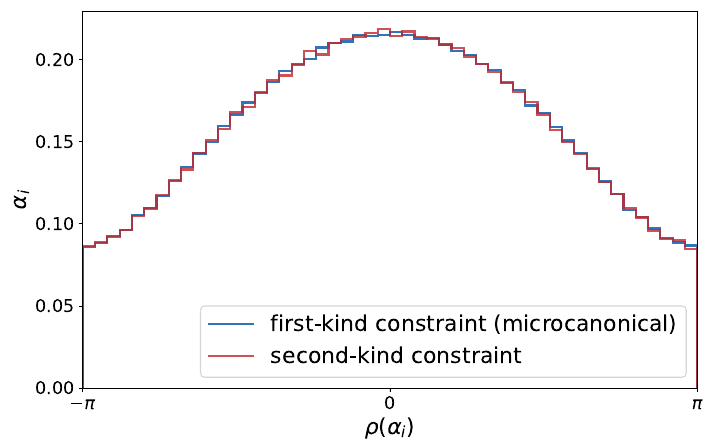
Figure 12. Polyakov loop phase distributions for N = 64 , n t = 32 , P = 0 . 2 , for constraints of the first and second kind.